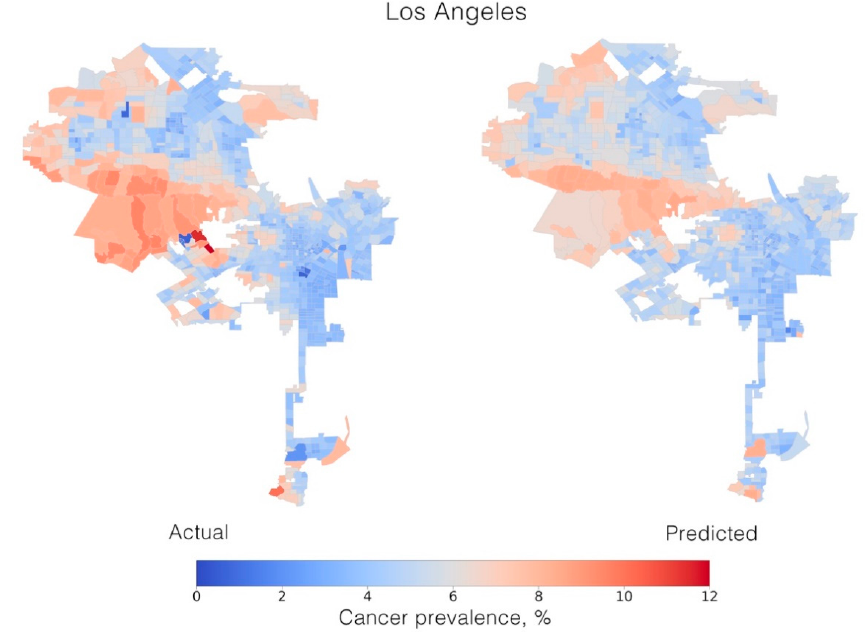
Figure 2. Maps of actual ( left ) and predicted ( right ) cancer prevalence in Los Angeles, CA, USA, at the census-tract level.